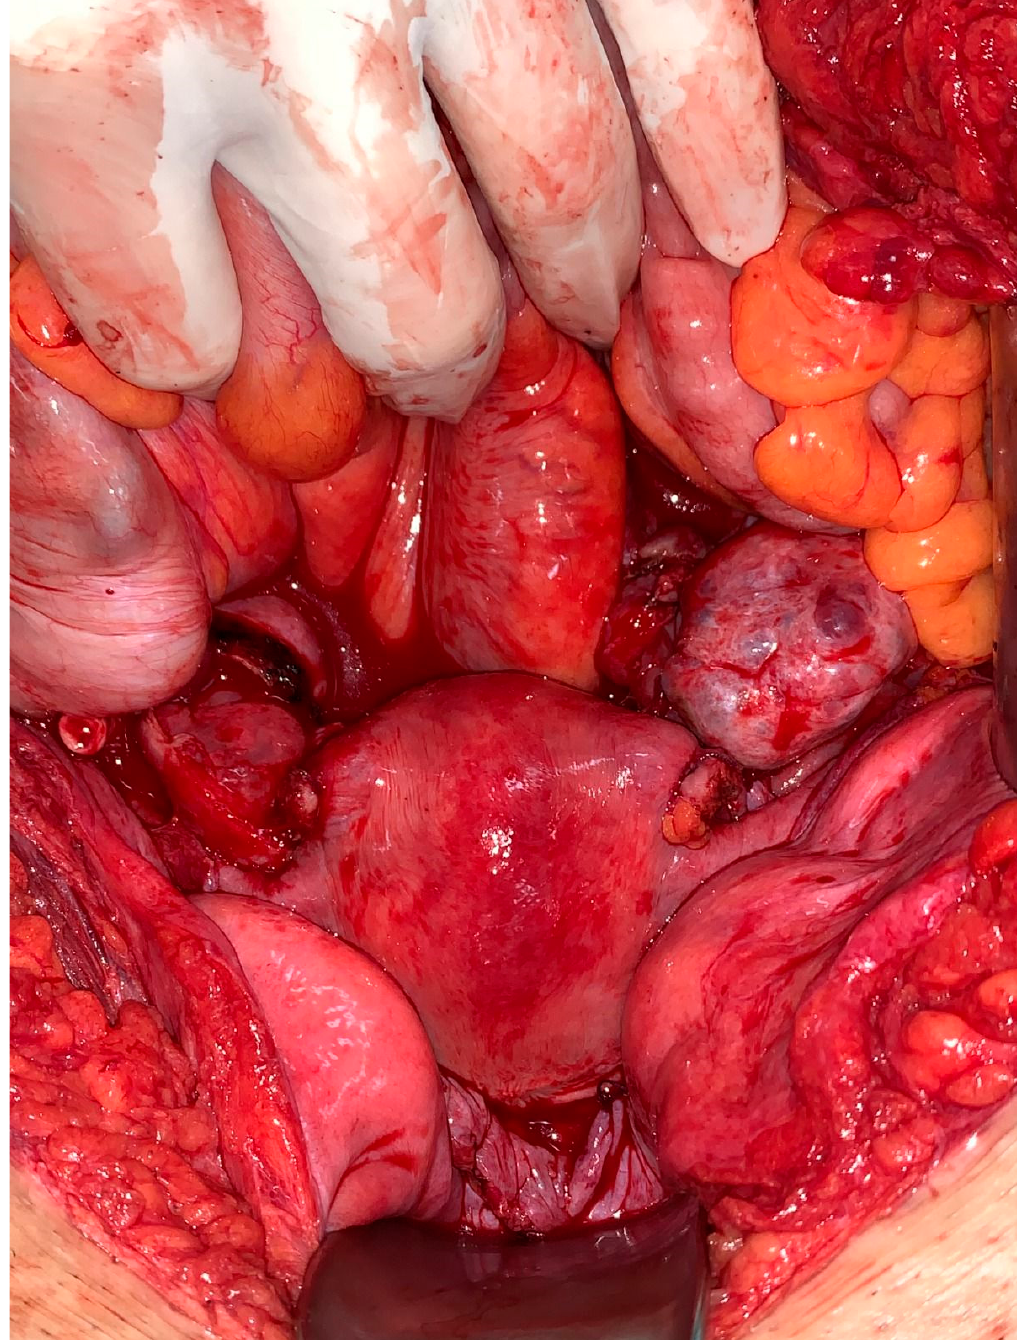
Figure 6. Uterine graft after the anastomosis of both uterine arteries and veins and ovarian veins. The red color of the graft was visible after removal of the bulldog clamps.